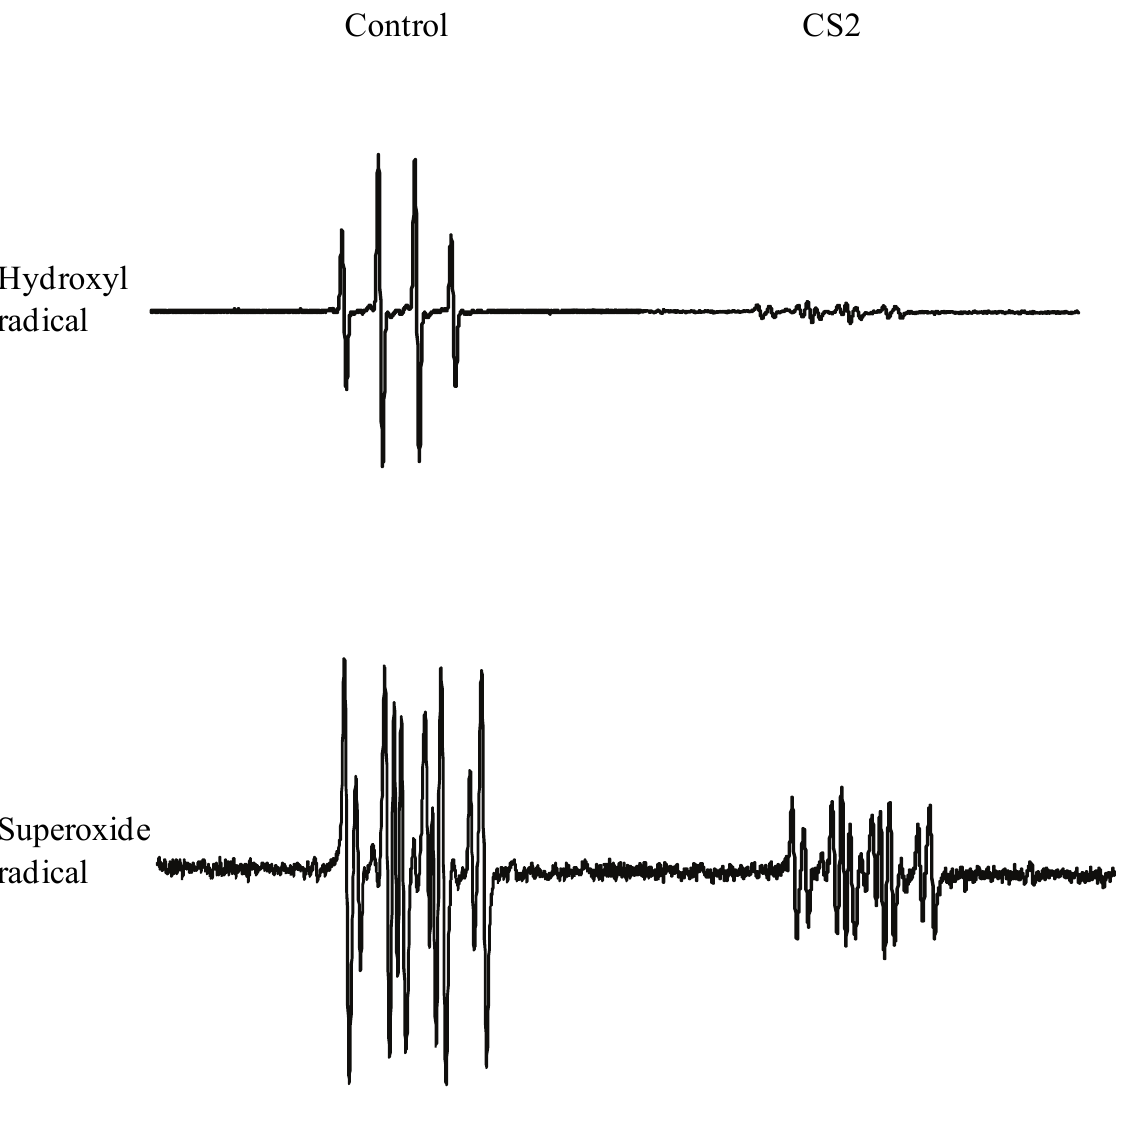
Figure 4. Comparison of ESR spectra of hydroxyl and superoxide radicals following treatment with different LMW chitosans at a concentration of 200 μ